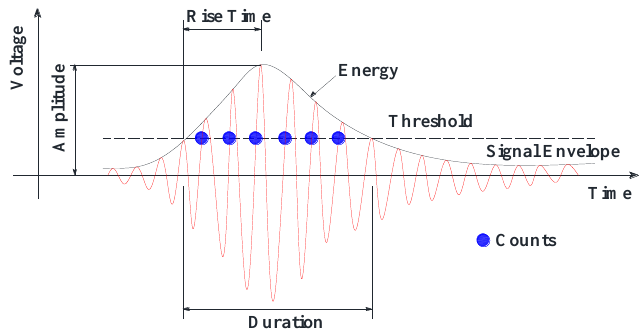
Figure 1. Typical acoustic emission signals and parameters.